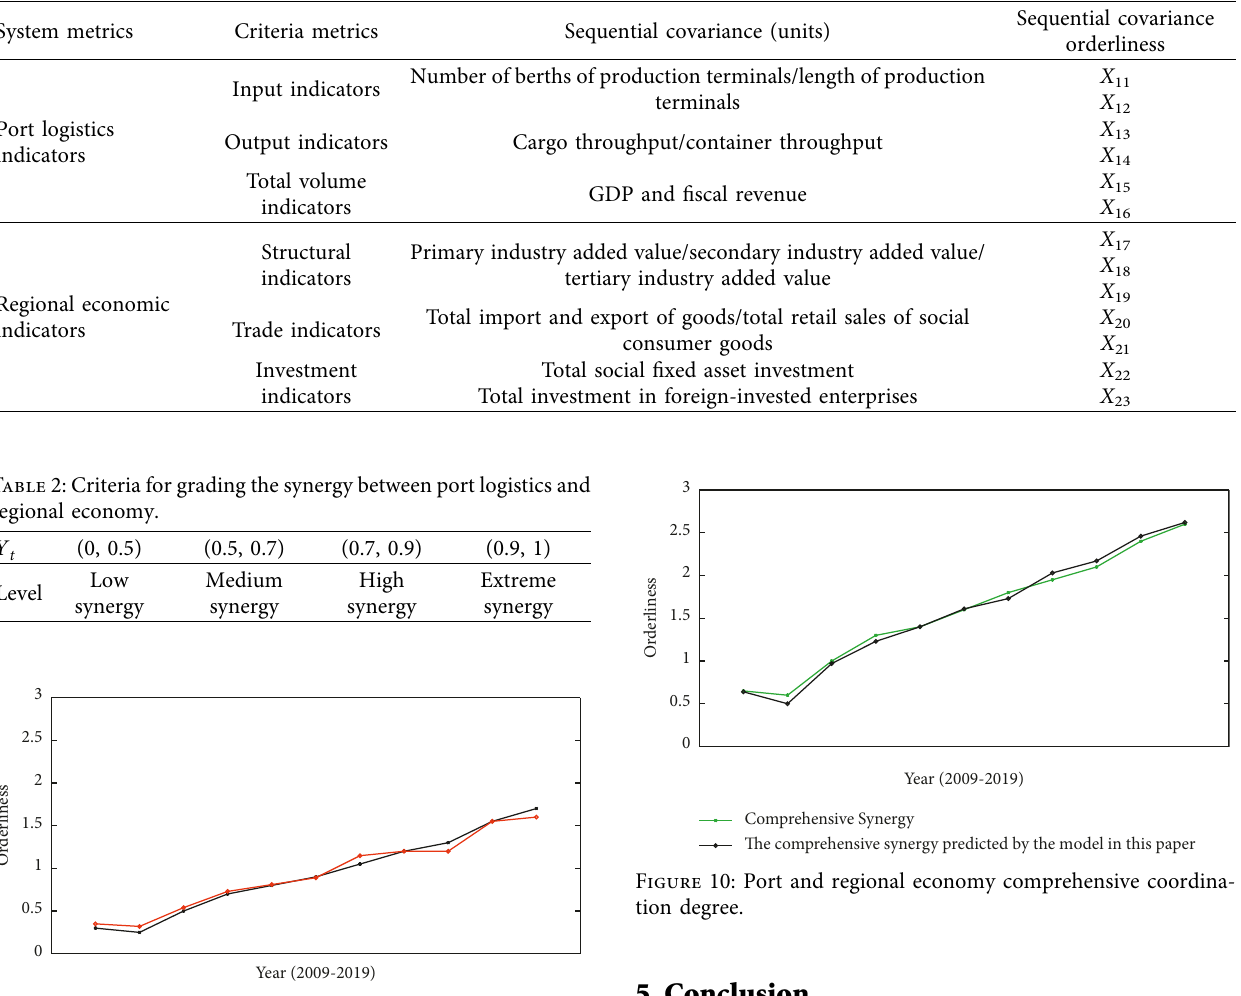
Table 1: Evaluation index system of synergy between port logistics and regional economy.